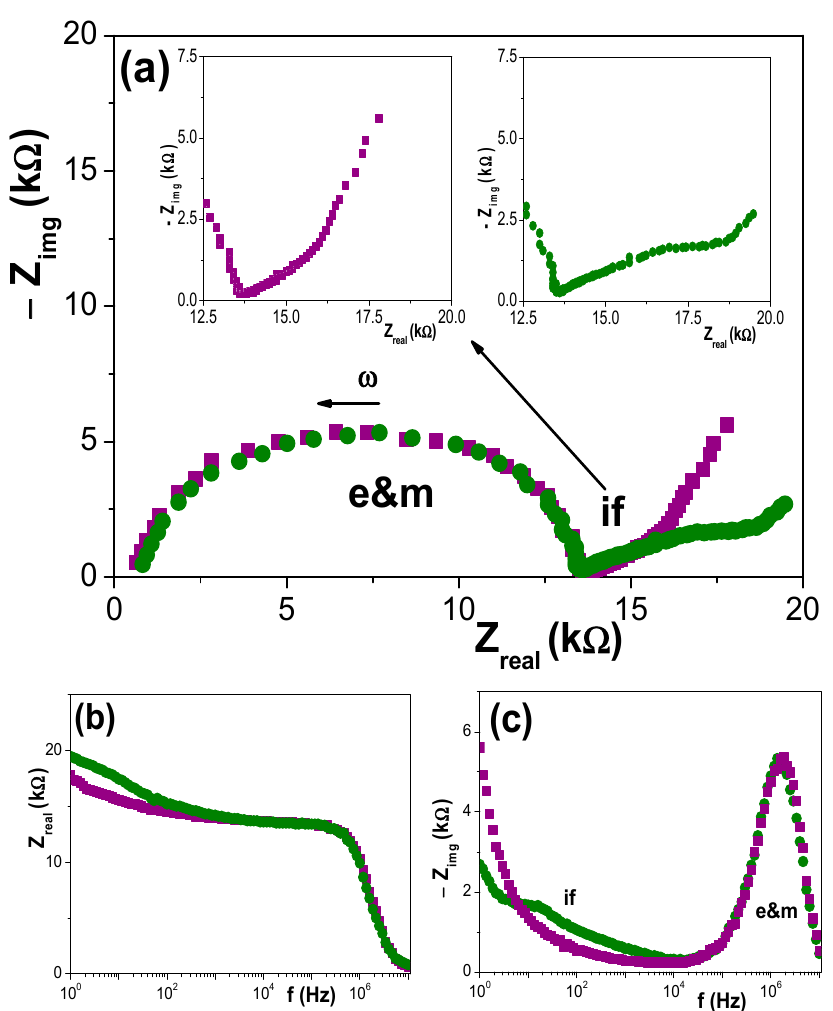
Figure 6. Comparison of impedance plots for Ox–SiO 2 /APTES ( ● ) and Ox–SiO 2 /APTES/O 3 ( ■ ) samples measured with 0.002 M NaCl solution. ( a ) Nyquist plot ( − Z img vs. Z real ); ( b ) Bode plot (Z real vs. frequency) and ( c ) Bode plot ( − Z img vs. frequency).